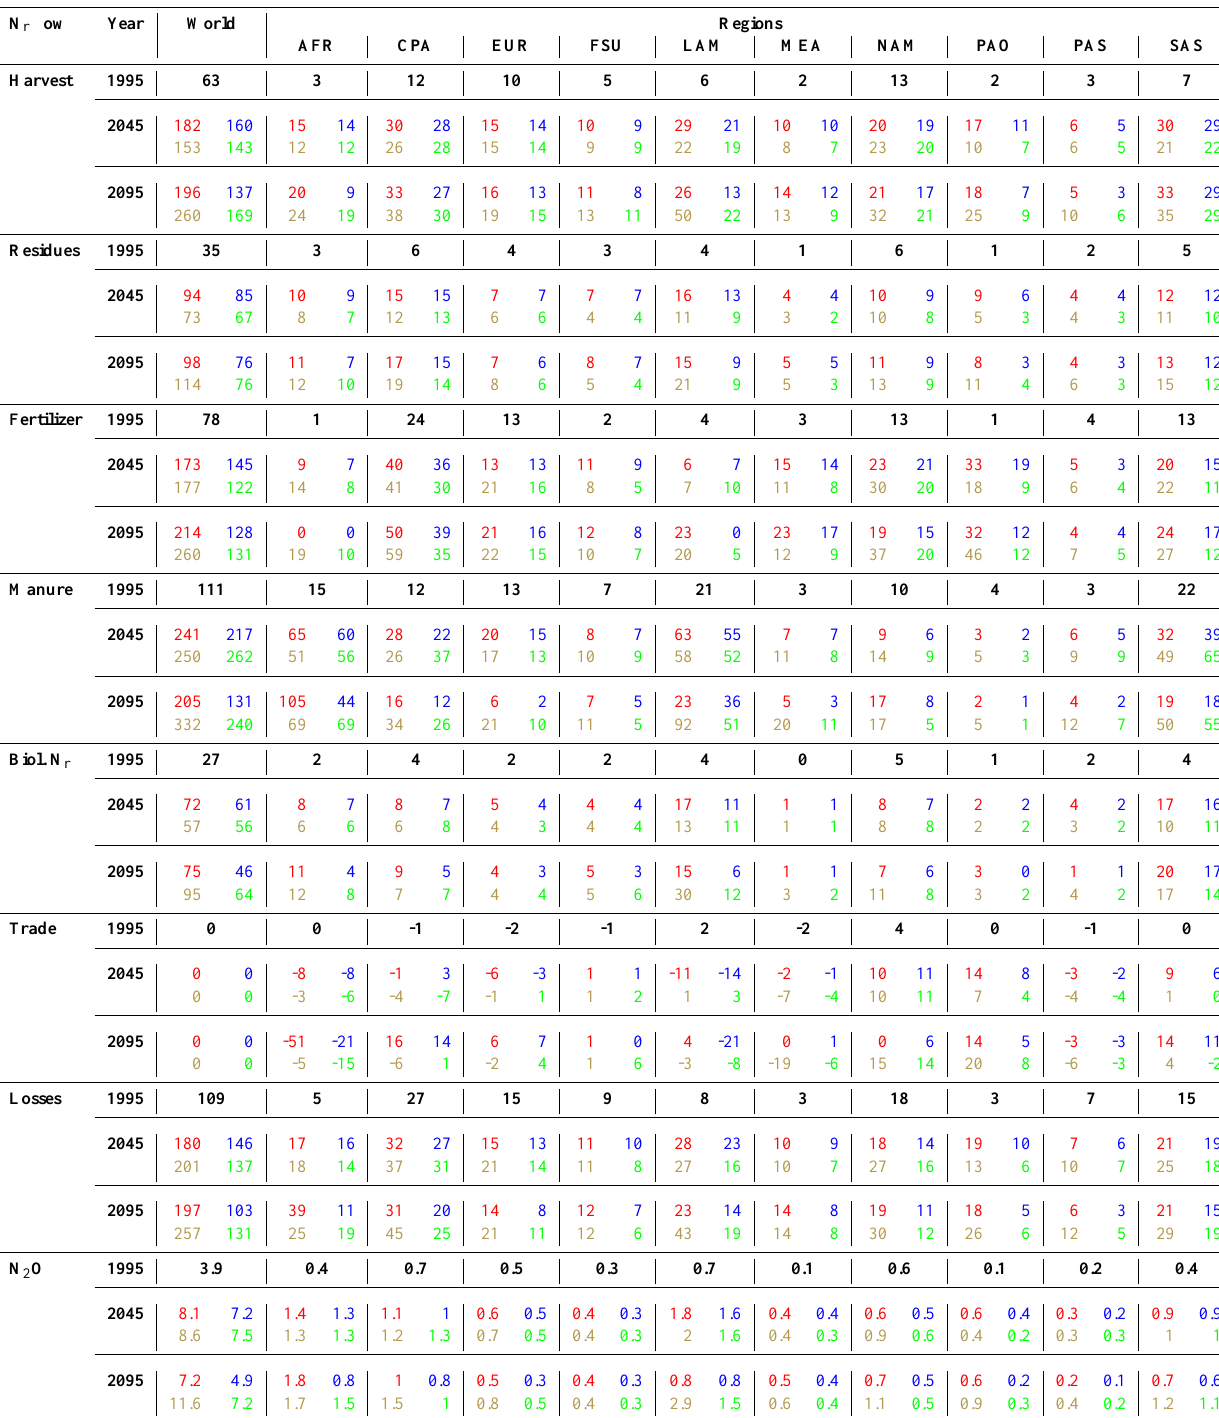
Table 2. Regional estimates of N r flows for the state in 1995 and for the four scenarios A 1 from cropland soils and animal waste